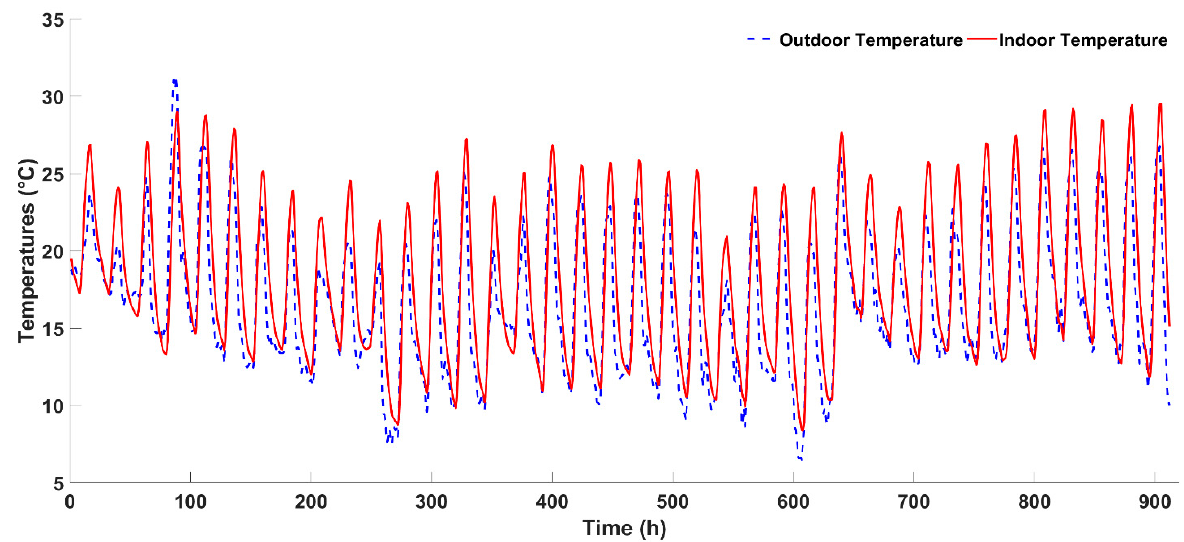
Figure 19. Simulated temperature evolution inside the building in response to weather conditions.